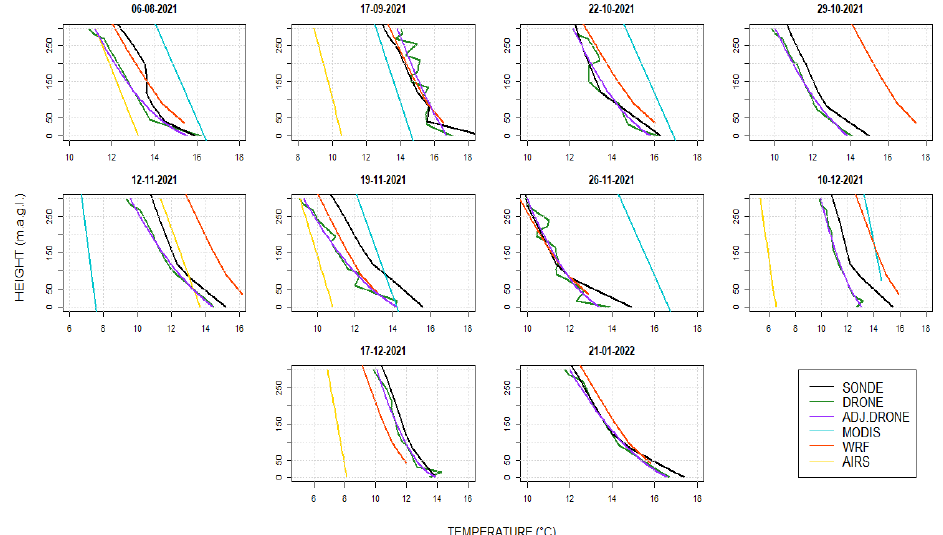
Figure 3. Temperature profiles measured with radiosonde (black), drone (green), drone quadratic interpolation (purple), MODIS (sky-blue), AIRS (yellow), and WRF (orange) up to 300 magl. for 10 measurement events.